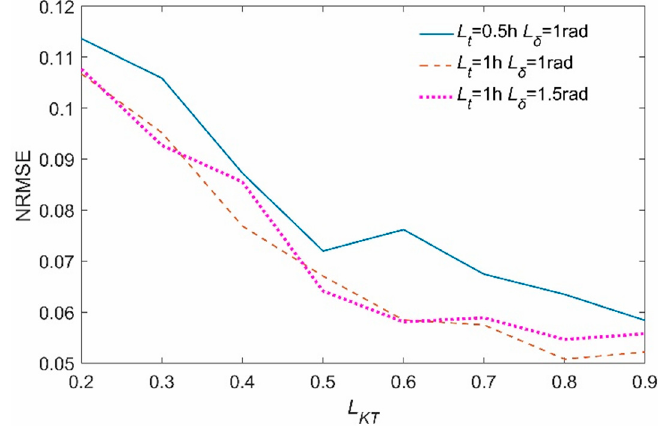
Figure 7. Values of normalized root mean square error ( NRMSE ) by using the different limits of the changes of t solar , δ , and K T .